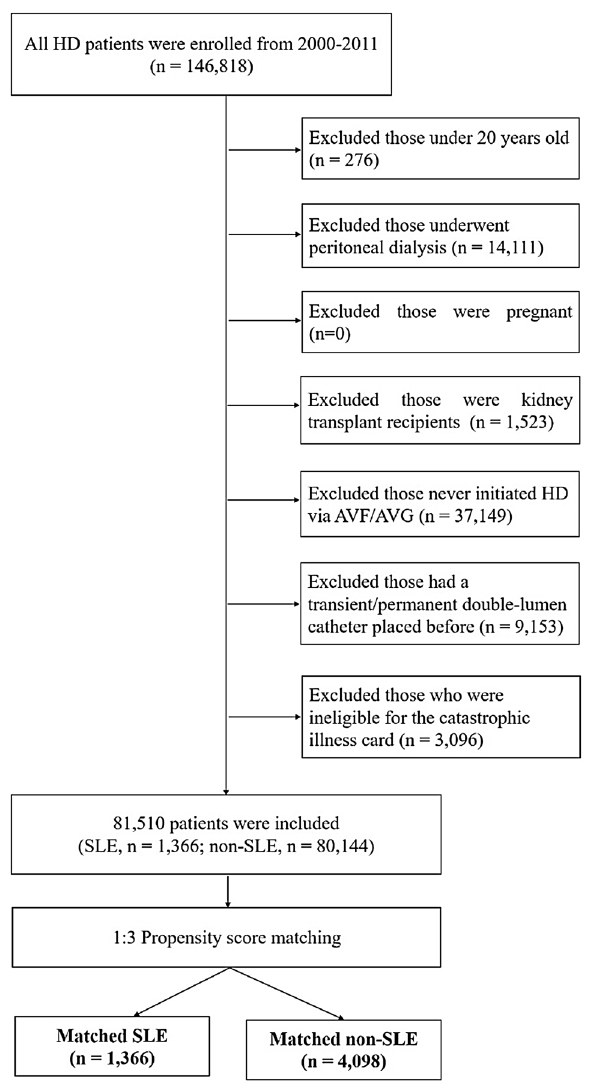
Figure 1. Flowchart of patient enrollment and propensity score